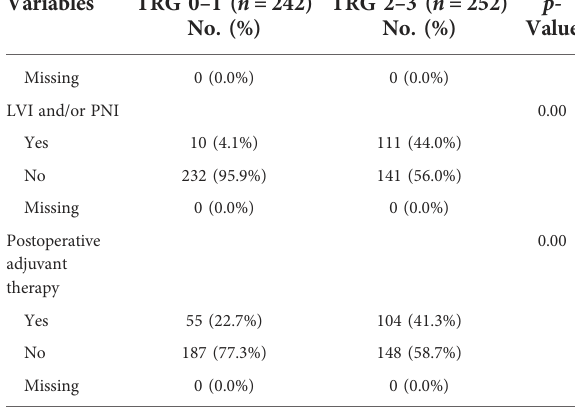
TABLE 2 Patient characteristics associated with tumor regression